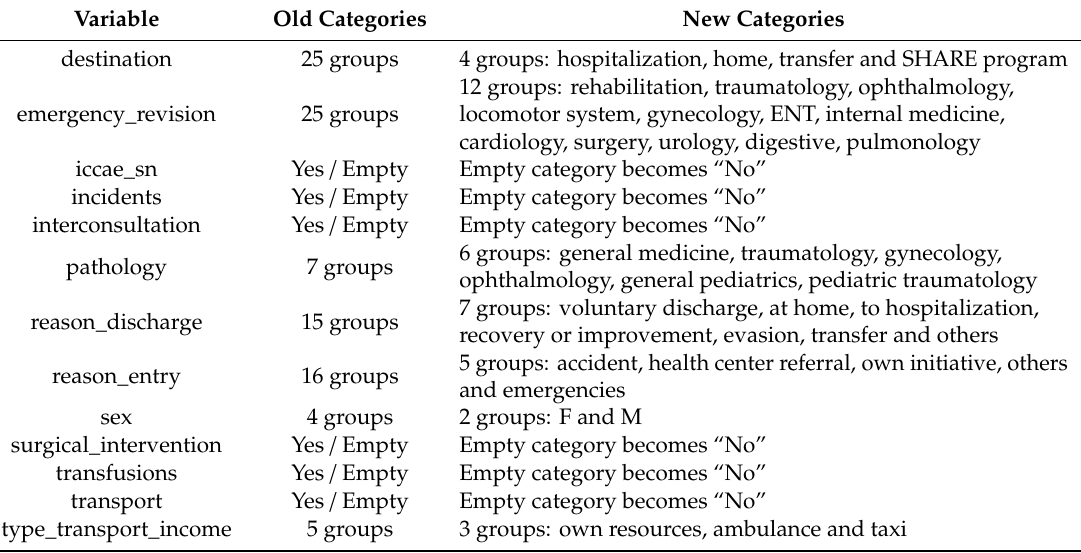
Table 4. Categorical Variable Modifications.